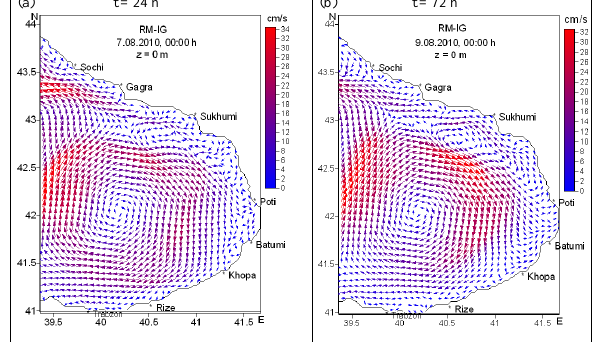
Fig. 3. Temperature field (deg. C) at 5.08.2010, 00:00 h on depths of 0 m (a) and 100 m (b).